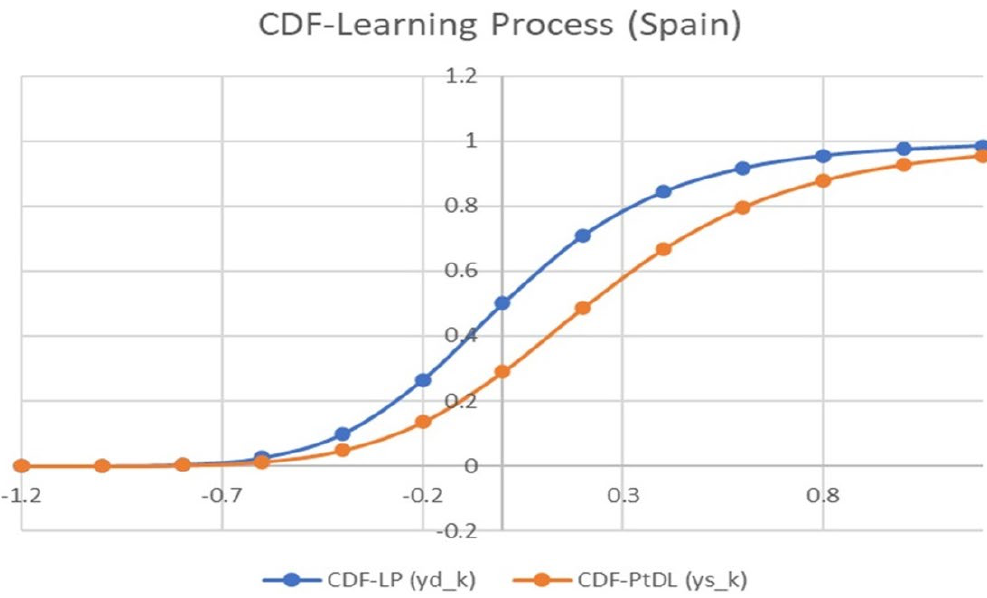
Figure 3. Cumulative distribution function PANAS-t model structure (Learning Stage - Spain)